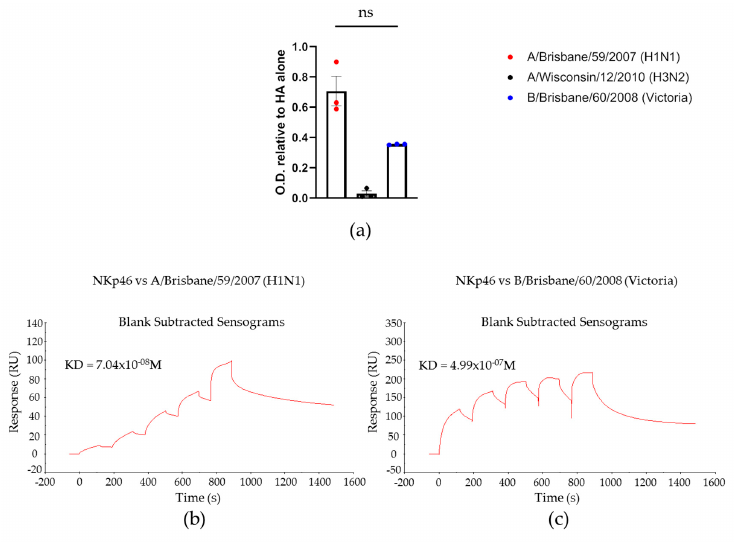
Figure 2. NKp46 binds the hemagglutinin protein of IAV better than IBV. ( a ) Plates were coated with the indicated recombinant HIS-tag labeled hemagglutinin proteins, incubated or not with NKp46-Ig and assayed for binding using ELISA. The results present the NKp46-Ig binding relative to the amount of HA coated on the plate (determined using an anti HIS-tag antibody). An ANOVA test was performed in order to evaluate significance. Figure shows cumulative results of three independent experiments. ( b , c ) SPR single cycle kinetics of NKp46 vs. the recombinant hemagglutinin proteins of IAV ( b ) and IBV ( c ). CM5 chip was coated with anti-HIS-tag antibodies and then bound with the recombinant HAs expressing HIS-tag. NKp46-Ig was injected with the highest concentration of 6.6 μ M in the left panel and 48.2 μ M in the right